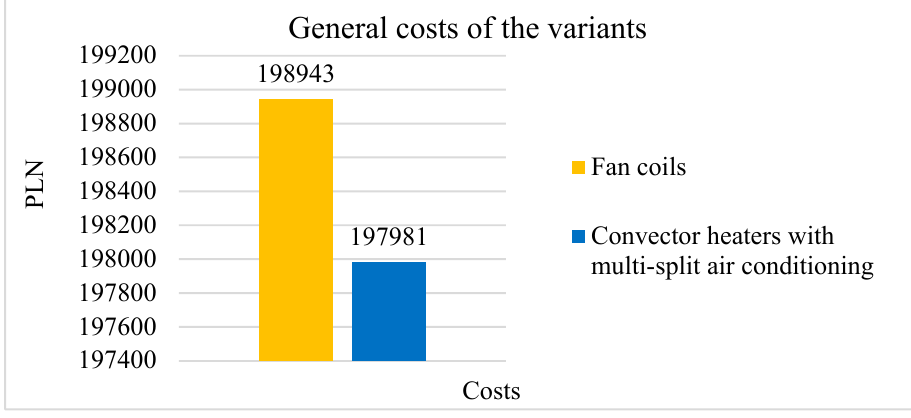
Figure 1. General costs of the variants